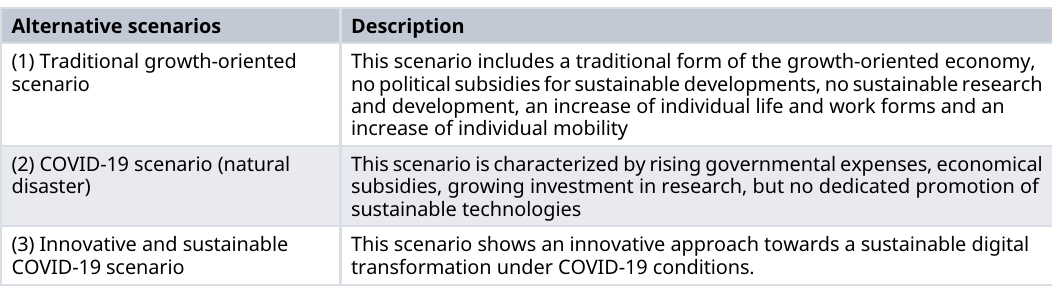
Table 11. Three alternative